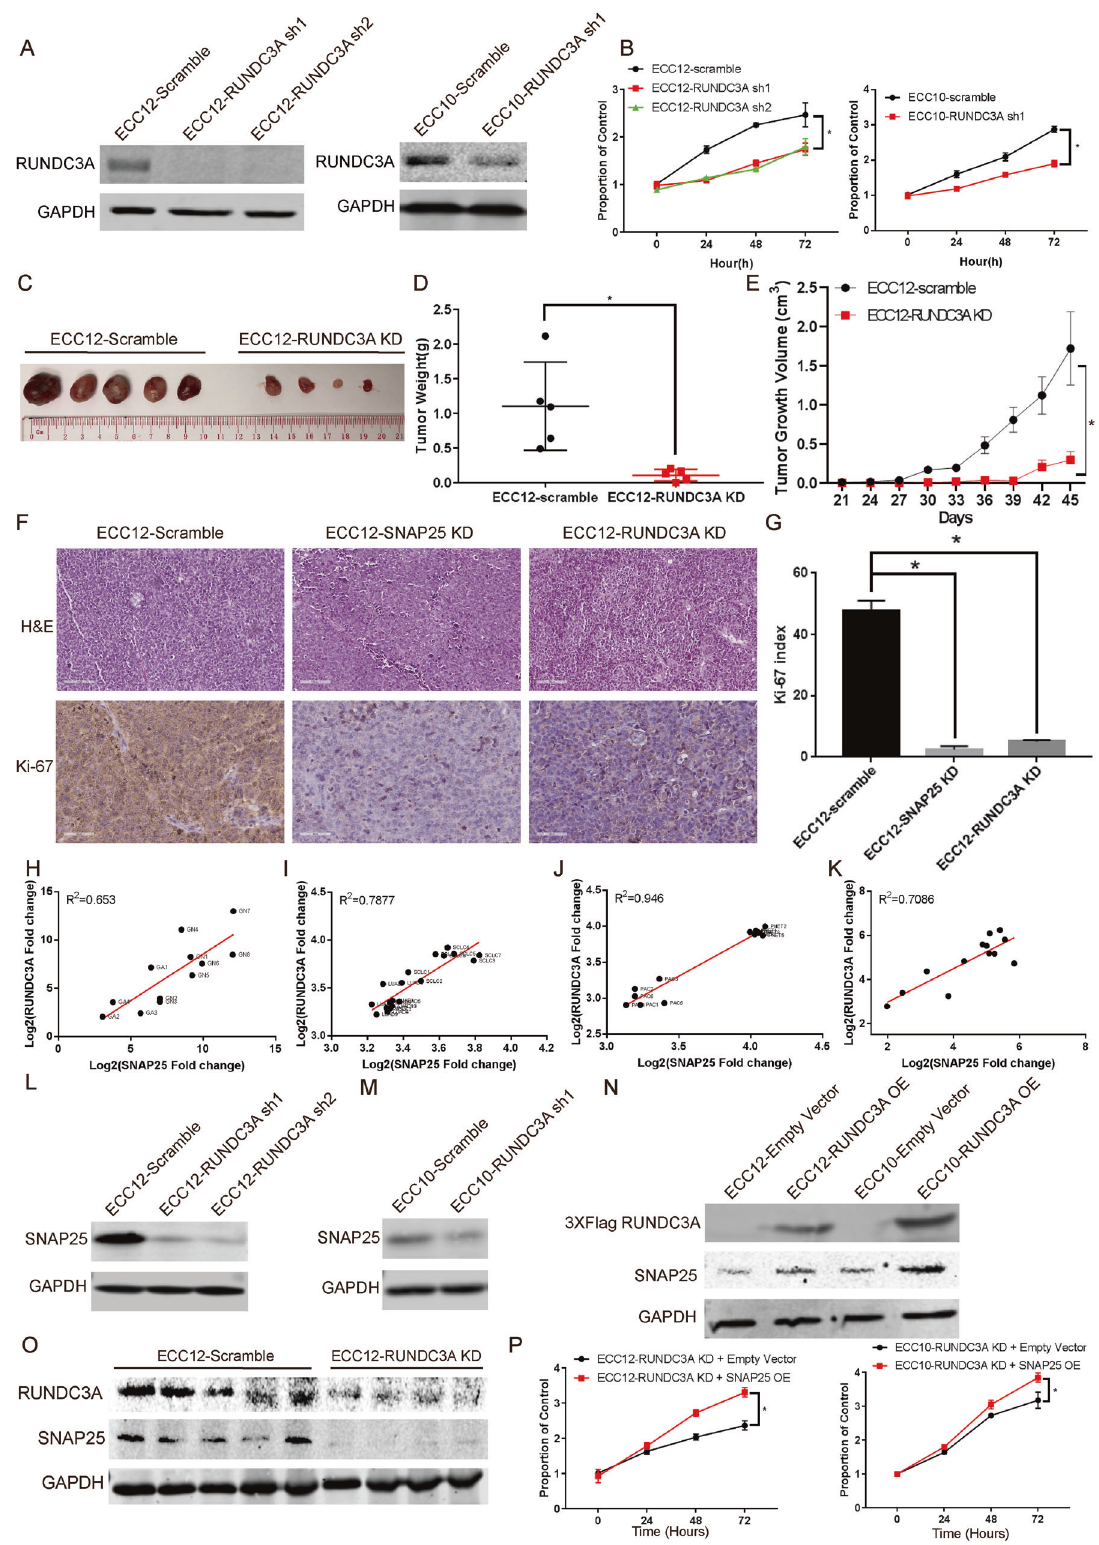
alone was 48 months, 20 months, and 12 months, respectively [14], which suggests that chemotherapy is not effective in treating GNEC and that treatment resistance will likely develop. Therefore, understanding the mechanism of chemoresistance in GNEC is